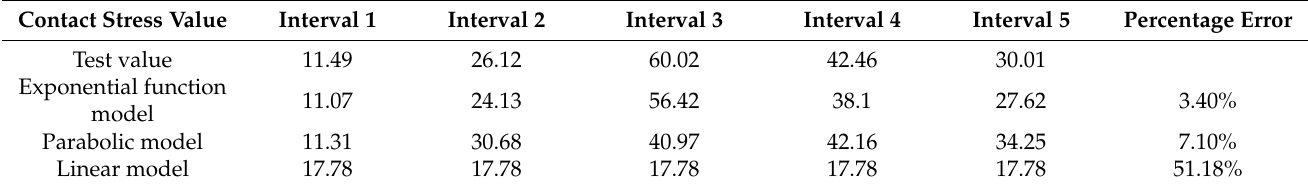
Table 3. Error comparison between different models and experimental stress values (N/cm 2 ) ( λ =